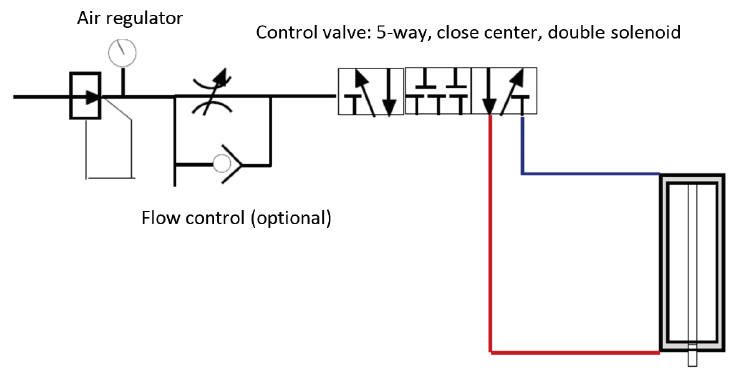
Figure 6. Schematic design of the pneumatic